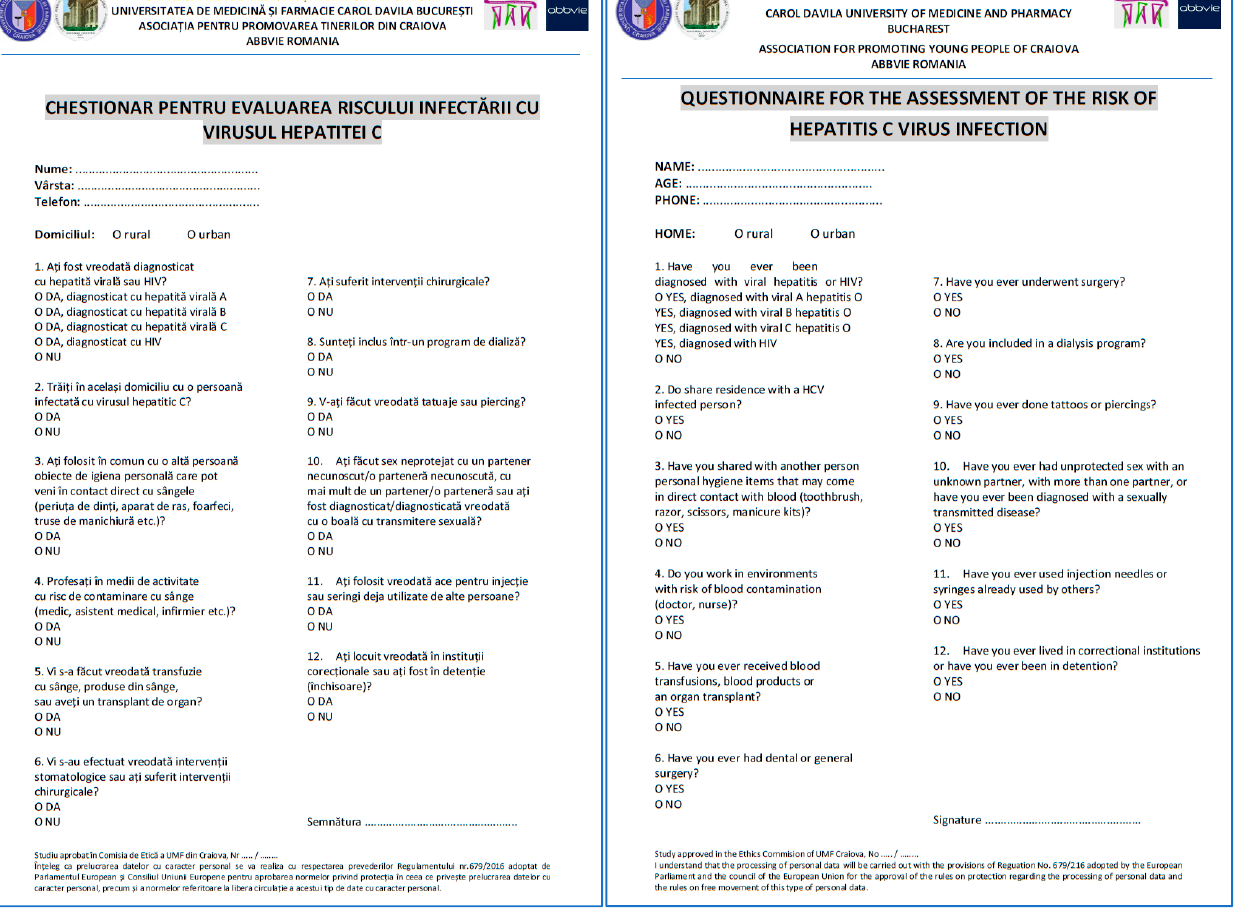
Figure 1. Survey questionnaire (original, in Romanian ( left ) and translated copy in English ( right )) used to determine risk factors in every patient.